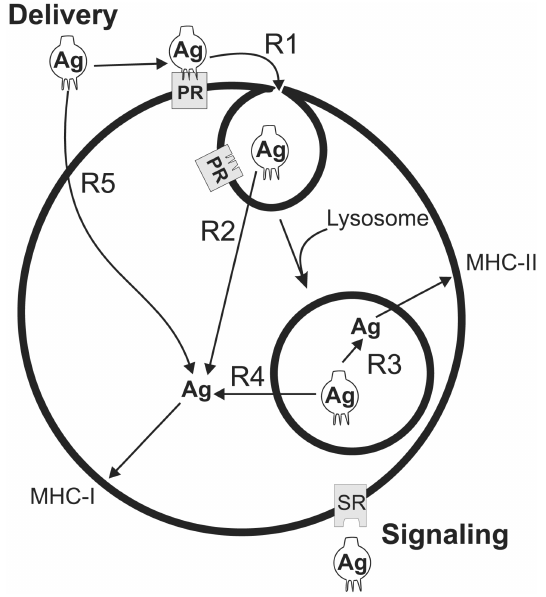
Figure 11. Hypothetical model for delivery of antigen (Ag) encapsu- lated in archaeosomes to MHC class I (MHC-I) and MHC class II (MHC-II) pathways of antigen presenting cells. A phagocytosis re- ceptor (PR) is shown interacting with an archaeosome vesicle to pro- mote endocytosis (R1). Fusion with lysosomes is shown to be followed by release of Ag (R3) for processing and presentation of peptides by MHC-II. Ag delivery to the cytosol for MHC-I presenta- tion may occur in theory by direct fusion of archaeosomes with the plasma membrane (R5), or fusion with the endosome (R2) or phagolysosome (R4) membranes. Cell signaling receptors may be ac- tivated by archaeosomes either before or after